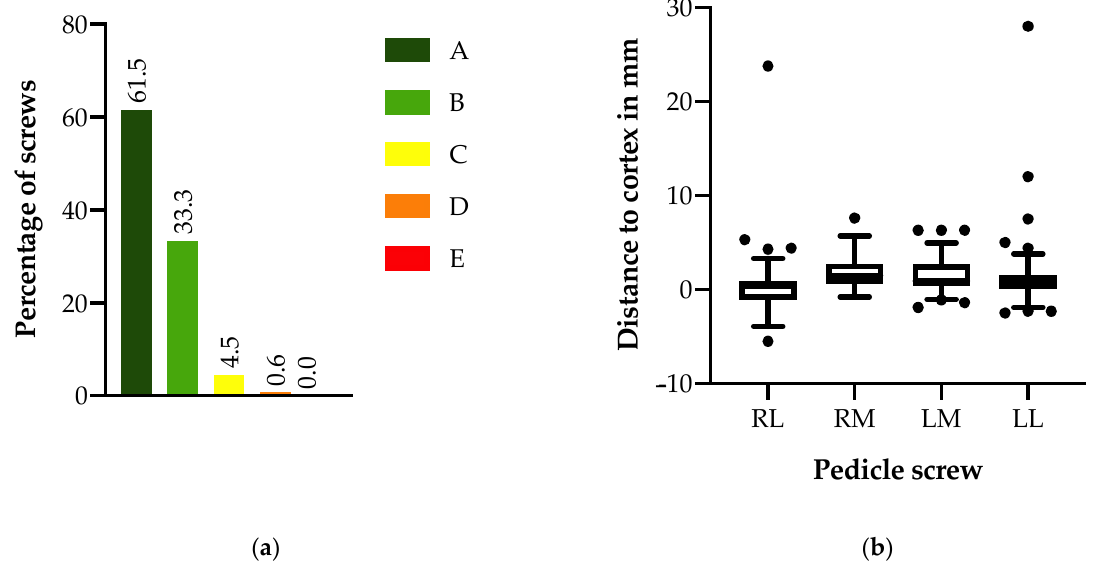
Figure 4. Screw accuracy: ( a ) percentage of screws according to different Gertzbein–Robbins system (GRS) grades. A: GRS grade A, B: GRS grade B, C: GRS grade C, D: GRS grade D, E: GRS grade E. ( b ) distance between the pedicle screws and the medial/lateral cortices with the area marked in red depicting perforations ≥ 2 mm. RL: right lateral, RM: right medial, LM: left medial, LL: left lateral.